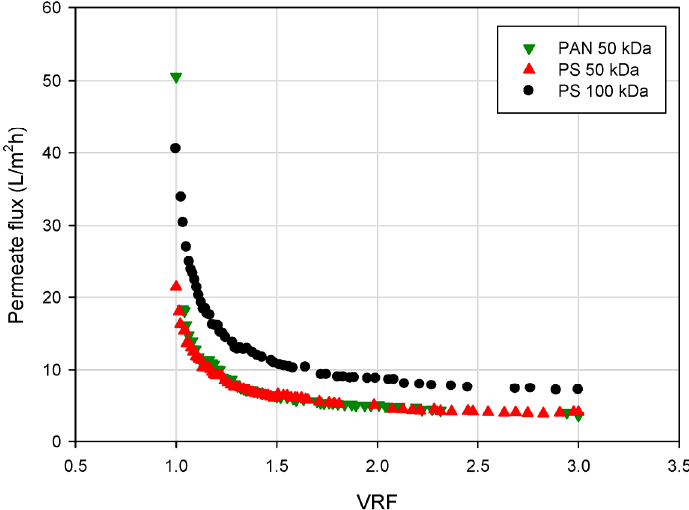
Figure 3. UF of blood orange juice. Effect of VRF on permeate flux (batch concentration configuration; TMP, 0.5 bar; Q f , 130 L/h; T, 20